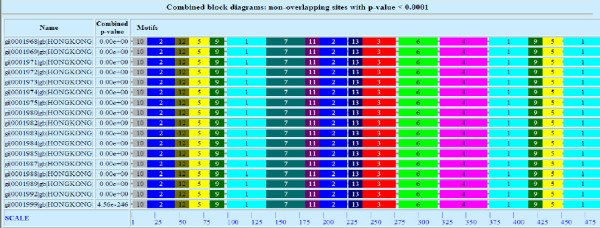
Selected 14 MEME Blocks in the HA1 consensus sequence from 1968–1999. Combined block diagram of non overlapping sites with p value < 0.0001 was generated from the MEME server which are common to the entire data set, with the exception of block 14 which occurs in only 16 of the 17 sequences.